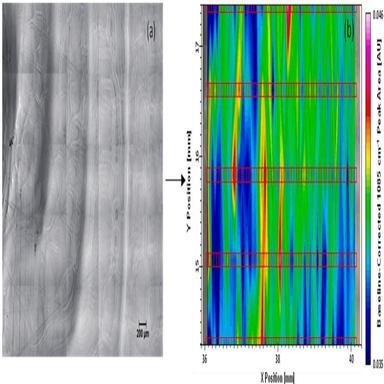
Composite microscopy image and corresponding map of the baseline-corrected ether peak area (1095 cm-1) over a 4 × 3 mm area of the printed coupon containing 2% nonylphenol showing the significant variation in ether peak area over the measured area. The red rectangles in (b) corresponds to measurement points. The colored regions are linearly interpolated in the y-direction between the neighboring points, including diagonally, and the height of the regions is therefore exaggerated.